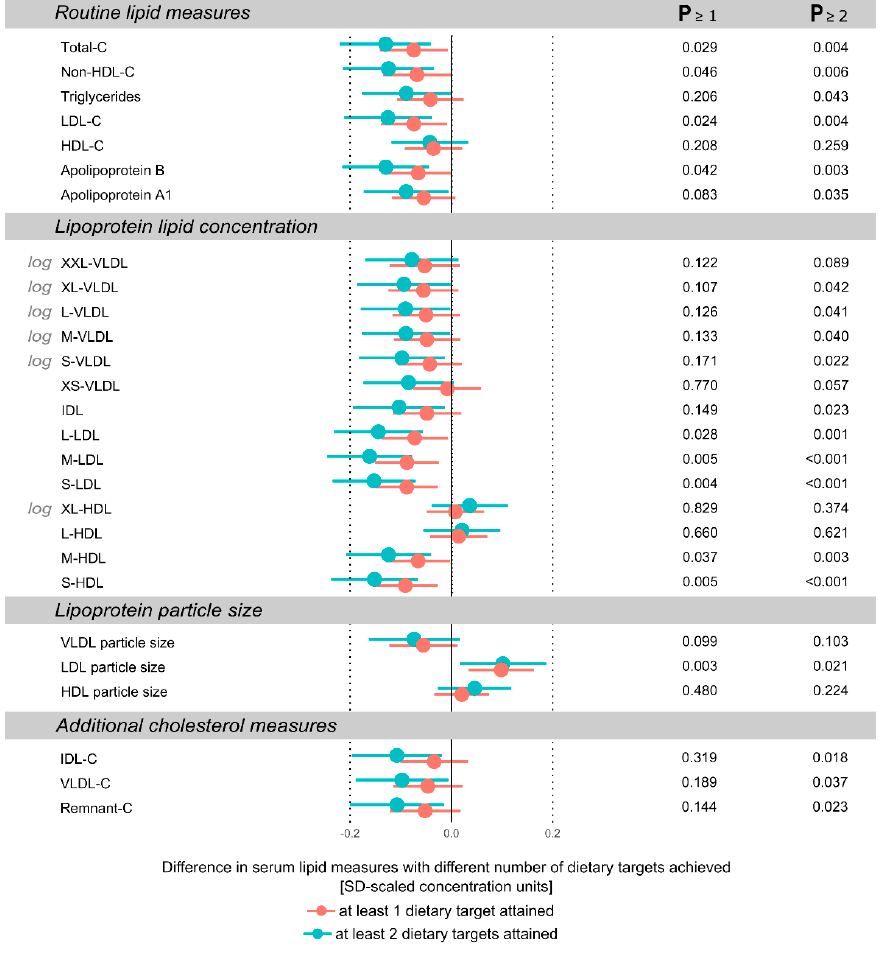
Figure 2. Differences in serum lipid measures between achieving the dietary targets compared to achieving none of the dietary targets. Effect estimates are standard deviation scaled differences between achieving zero dietary targets with respect to achieving ≥ 1 (red) or ≥ 2 (blue) of the targets. Error bars indicate 95% confidence intervals. Lipid measures are from pooled analyses across the six time points, and those with skewed distributions were log(x + 1)-transformed prior to analyses. C, cholesterol; HDL, high-density lipoprotein; LDL, low-density lipoprotein; VLDL, very low-density lipoprotein; IDL, intermediate-density lipoprotein.